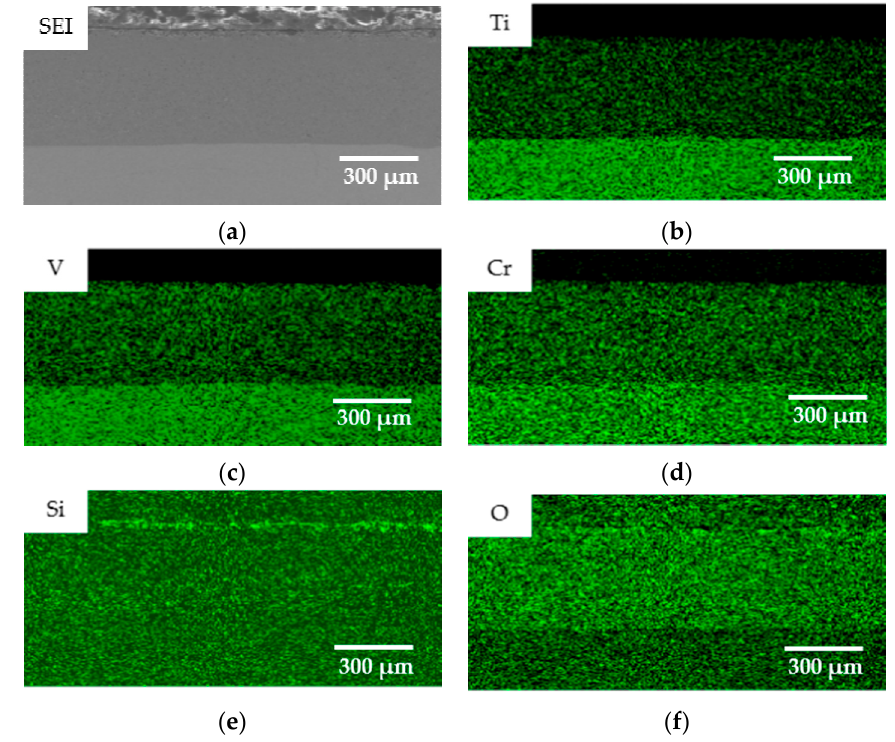
Figure 5. SEM morphology and EDS mapping of the oxide layer in TF550 alloy after oxidation at 1073 K for 100 h. ( a ) SEI; ( b ) Ti element; ( c ) V element; ( d ) Cr element; ( e ) Si element; and ( f ) O element.